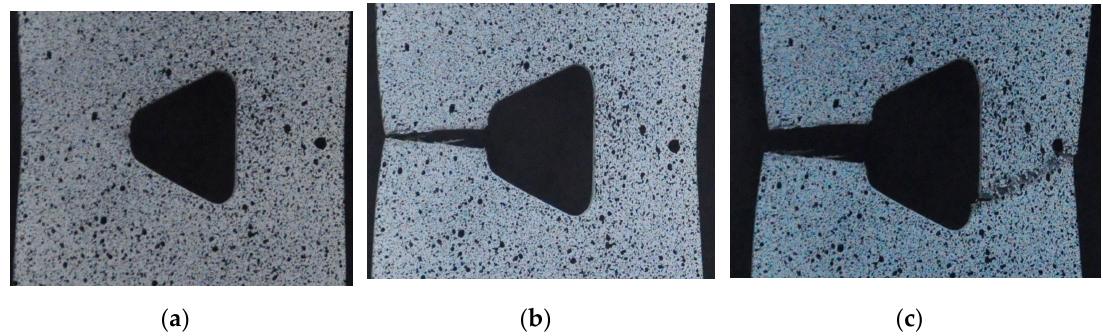
Figure 14. Tensile behavior of S235JR + N: ( a ) engineering σ – ε curve for plate with triangular with corner fillet radius; and ( b ) magnified initial part of the curve.